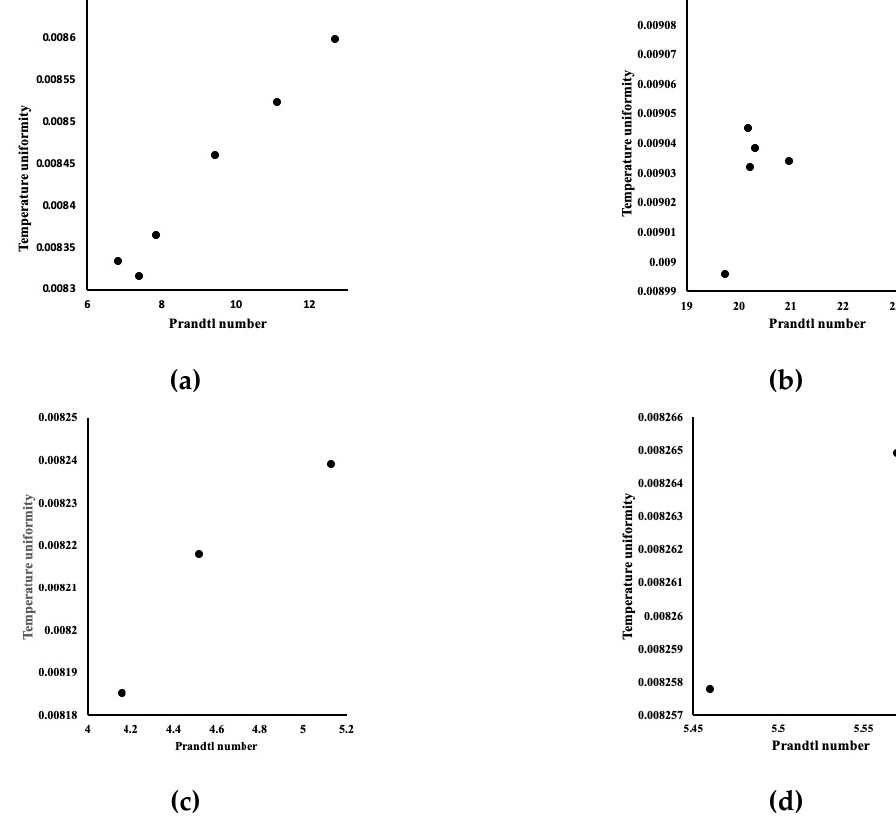
Figure 8. Temperature uniformity for all mixtures. ( a ) Al 2 O 3 –Cu mixtures, ( b ) SiO 2 –TiO 2 mixtures, ( c ) MWCNT–Fe 3 O 4 mixtures, ( d ) ND–Fe 3 O 4 mixtures.